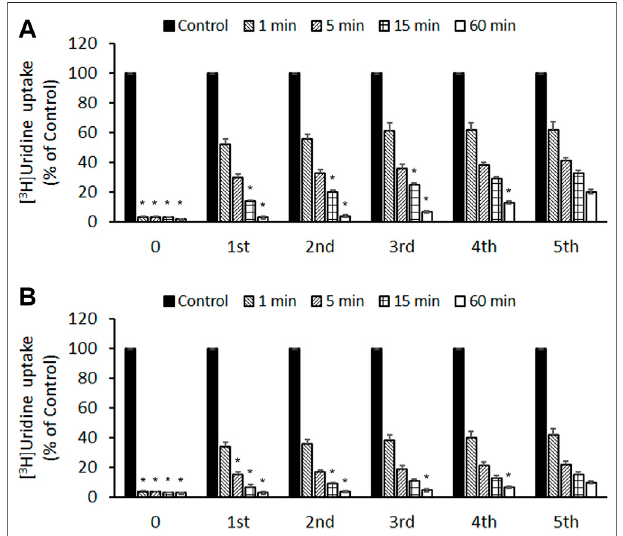
FIGURE 6 | Reversibility of the inhibitory effects of compound 3c on ENT1 and ENT2 (A) PK15NTD/ENT1 and (B) PK15NTD/ENT2 cells were incubatedwith50 μ Mofcompound 3c oravehicle(0.5%DMSO,asacontrol) for different time (0 – 60 min) The cells were then washed fi ve times. After wash-out for every single time [ 3 H]uridine uptake (1 μ M, 2 μ Ci/ml) was measured. Data are presented as mean ± SE of three experiments. * p < 0.05 compared with the fi fth